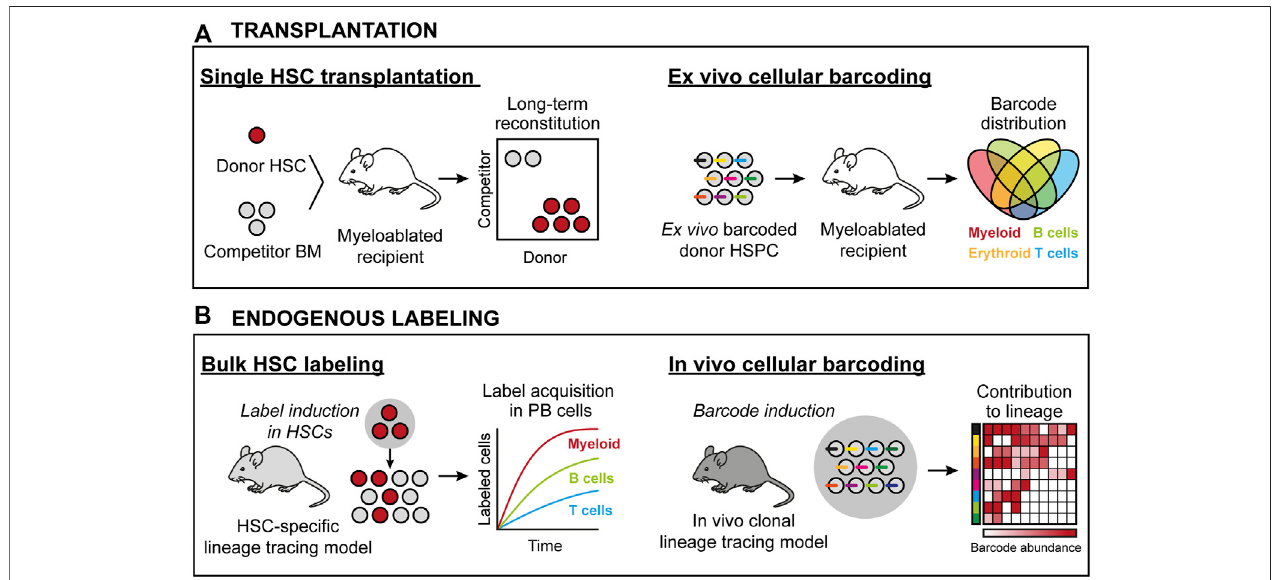
FIGURE 1 | HSC lineage tracing techniques in the mouse. (A) Transplantation-based approaches. Left: Transplantation of prospectively isolated candidate HSCs permits for assaying HSC activity at the single cell level. Here, all donor progeny in the mouse is derived from one cell. Right: Transplantation of ex vivo barcoded HSCs allows for monitoring the frequency of individual barcodes/clones from a population of HSCs. Here, donor progeny is derived from multiple HSCs, with the clonality assigned retrospectively by the identity and frequency of individual barcodes in de fi ned cell subsets. (B) Approaches to assess native HSC activity. Left: Using geneticdrivers,irreversiblerecombinationeventsareinducedthatpermitthetracingofaheritabledonormarker.Here,thecontributionfromapoolofHSCsismeasured in de fi ned progenitors based on the induced donor marker. Right: Endogenous clonal HSC lineage tracing. Here, the ability to induce unique donor markers in each cell permits for the clonal assessments similar to as in (A) .